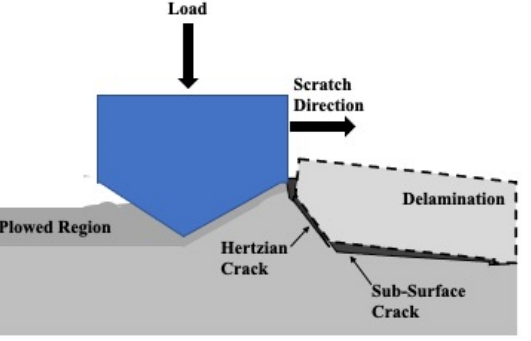
Figure 25. SEM Image of Hertzian Crack, Delamination, and Particle Removal on the 100 Pass Wear Track on the 4 μ m Thick Ni-P-NiTi Coating.